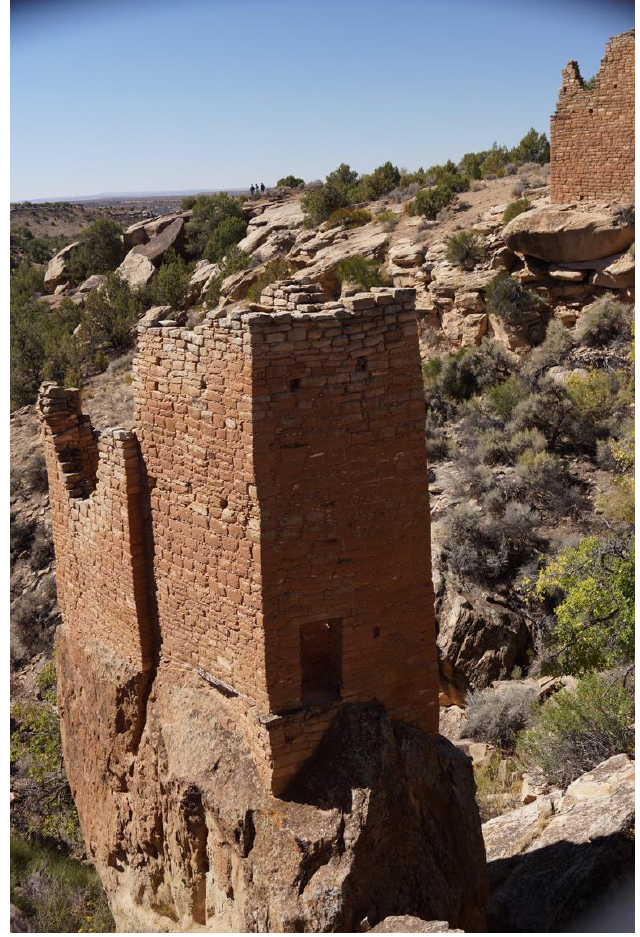
Figure 20. Square Tower atop Large Stone at the Head of a Canyon next to a Spring at